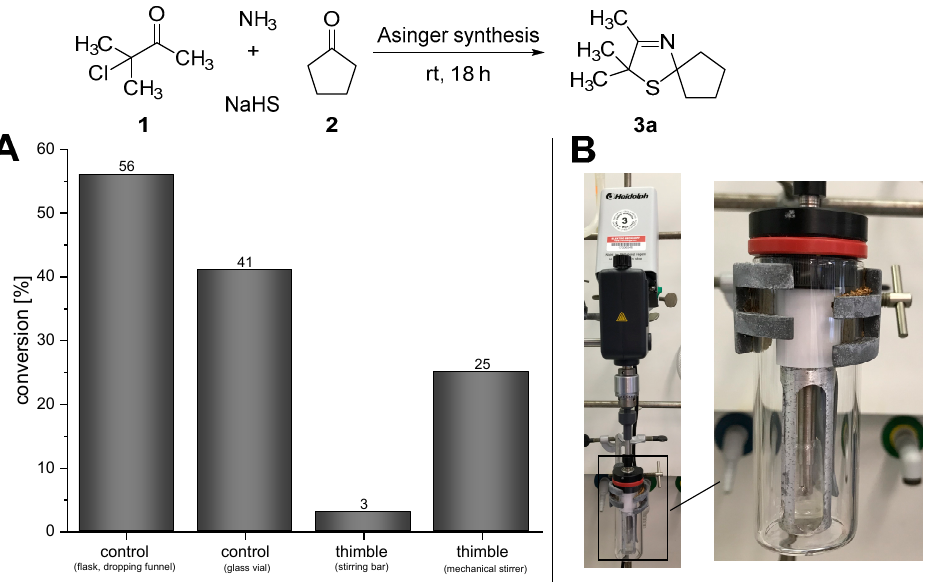
Figure 2. ( A ) Results for the Asinger-type multi-component reaction under different conditions. ( B ) Mechanical stirrer based on a KPG stirrer for high stirring speed inside the PDMS thimble.